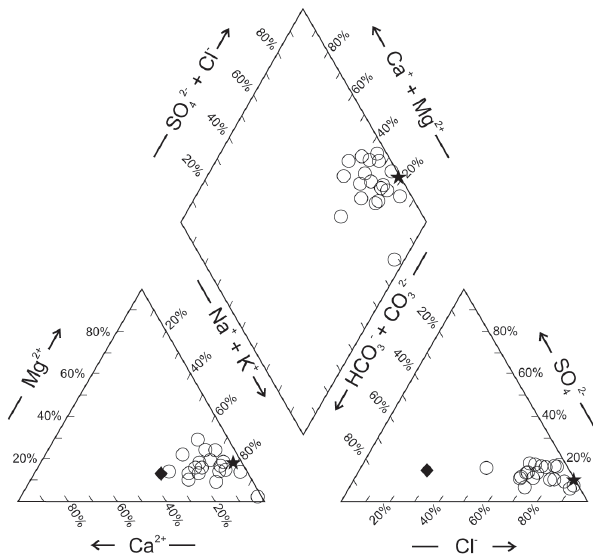
Fig. 3. Relative amounts of major ions analysed in sampled waters plotted in a Piper plot. Filled diamonds indicate rainwater; filled stars indicate